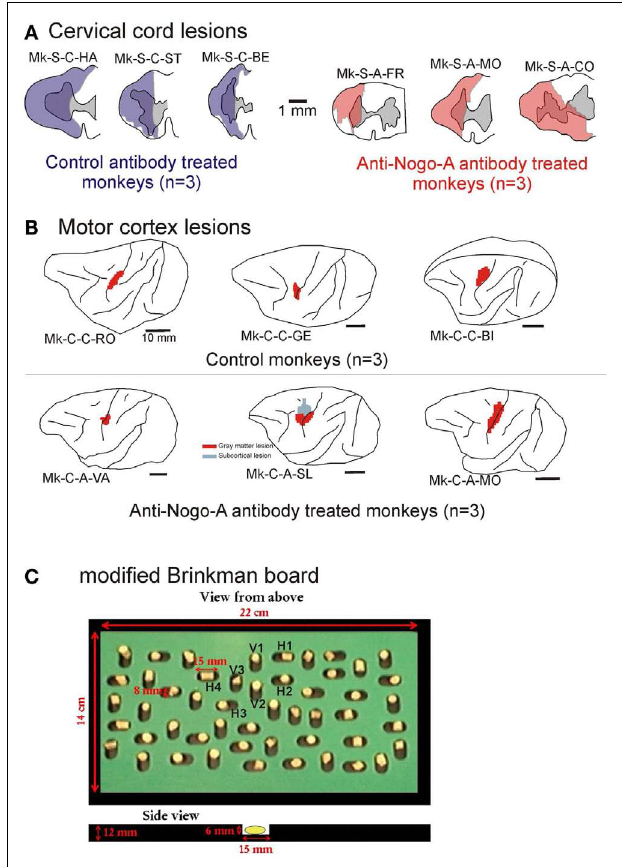
FIGURE 1 | (A) Cross-section reconstruction in the transversal plane of the lesion position and extent (blue or red area) for the six monkeys subjected to cervical cord lesion.The gray area represents the gray matter.These lesions were illustrated in previous reports (10, 11, 18, 30, 31). (B) Lateral view of the left hemisphere for the six monkeys subjected to a lesion of the hand representation in M1.The red areas correspond to the lesion territory in the gray matter, as seen by transparency of the cortical surface (possible lesion territory in the white matter below the lesioned gray matter is not represented, except in Mk-C-A-SL where a lesion in the white matter, medial to the lesion in the gray matter, is also represented).These lesions were illustrated in previous reports (12, 13, 20, 21).The procedures to reconstruct the lesion and determine the volume of the cortical lesion were described in a recent report (21). (C) View from top of the modified Brinkman board, showing the position of the 25 horizontal and 25 vertical slots, filled with a pellet. Below, side view of an individual slot. H1–H4 are the four horizontal slots considered to assess movement types executed by the monkeys for this orientation.V1–V3 are the three vertical slots from which movement types were assessed for this